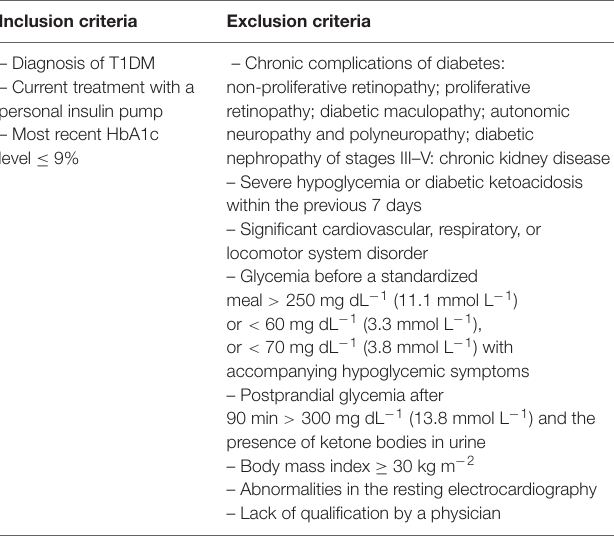
TABLE 1 | The T1DM group inclusion and exclusion